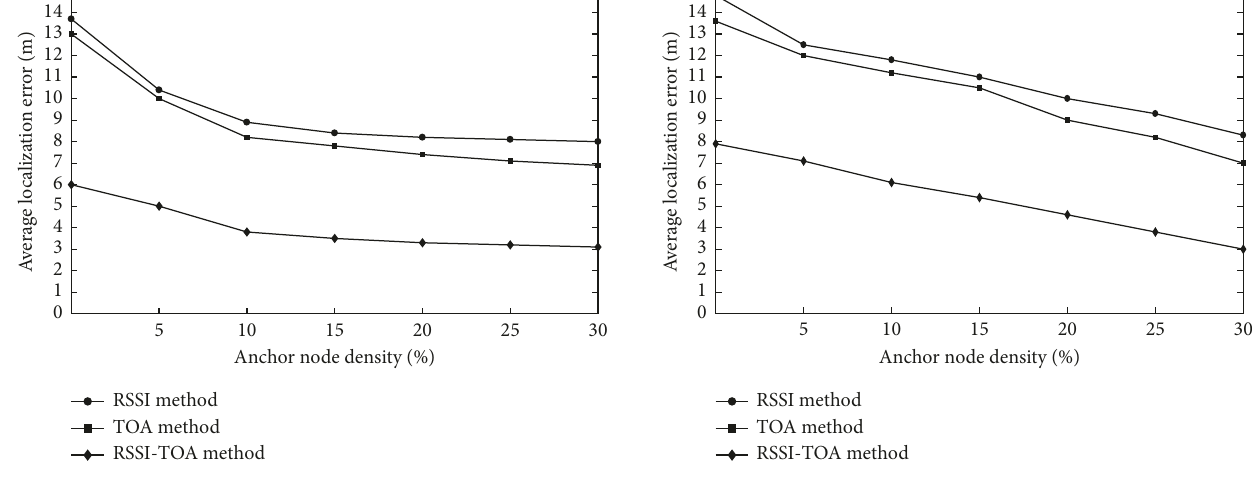
Figure 5: Relationship between localization error and anchor node density with mobile anchor nodes.